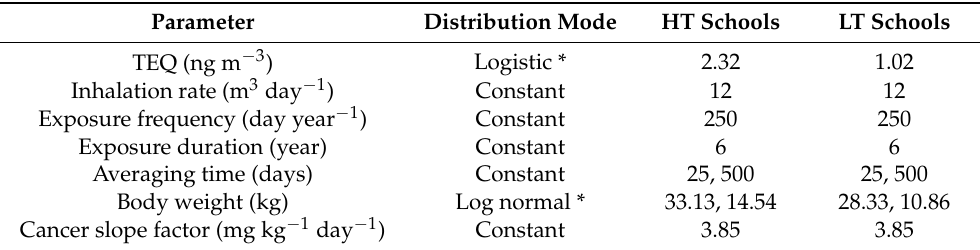
Table 1. The variable distribution types applied in the Monte Carlo simulation for both schools in HT and LT areas. Parameter Distribution Mode HT